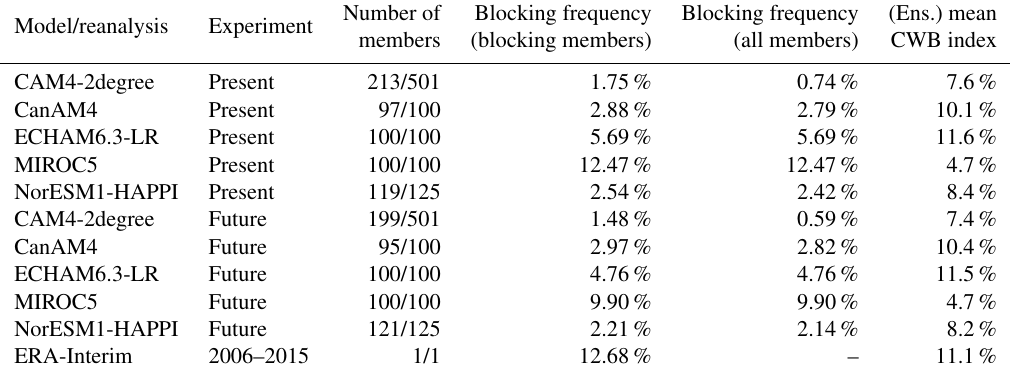
Table 1. For all models and experiments, this table provides the number of members which have at least 1d with Greenland blocking, as defined by the 10% threshold of the blocking index, out of the total number of members, the mean wintertime frequency of blocked days (blocking frequency in the table) over those selected members, and the ensemble mean wintertime frequency of blocked days taking into account all members (as in Fig. 2). If all members exhibit blocked days, the mean frequency (fourth column) equals the full ensemble mean frequency (fifth column). The last column gives the (ensemble) wintertime mean of the CWB index (all winter days are taken into account) in percent of the box area as defined in Sect. 2.4. A value of 100% would mean that every grid point in the box exhibits CWB.